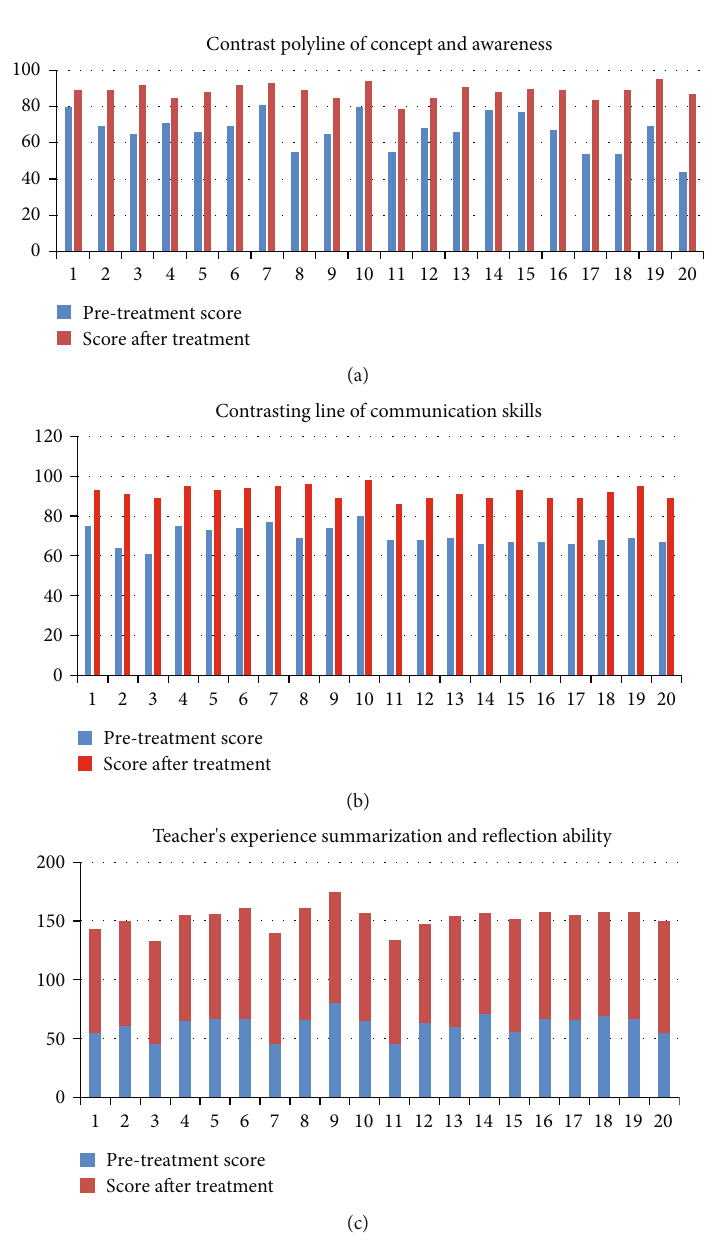
Figure 7: Comparison of teachers ’ ability before and after the implementation of the scheme in the home-school collaborative